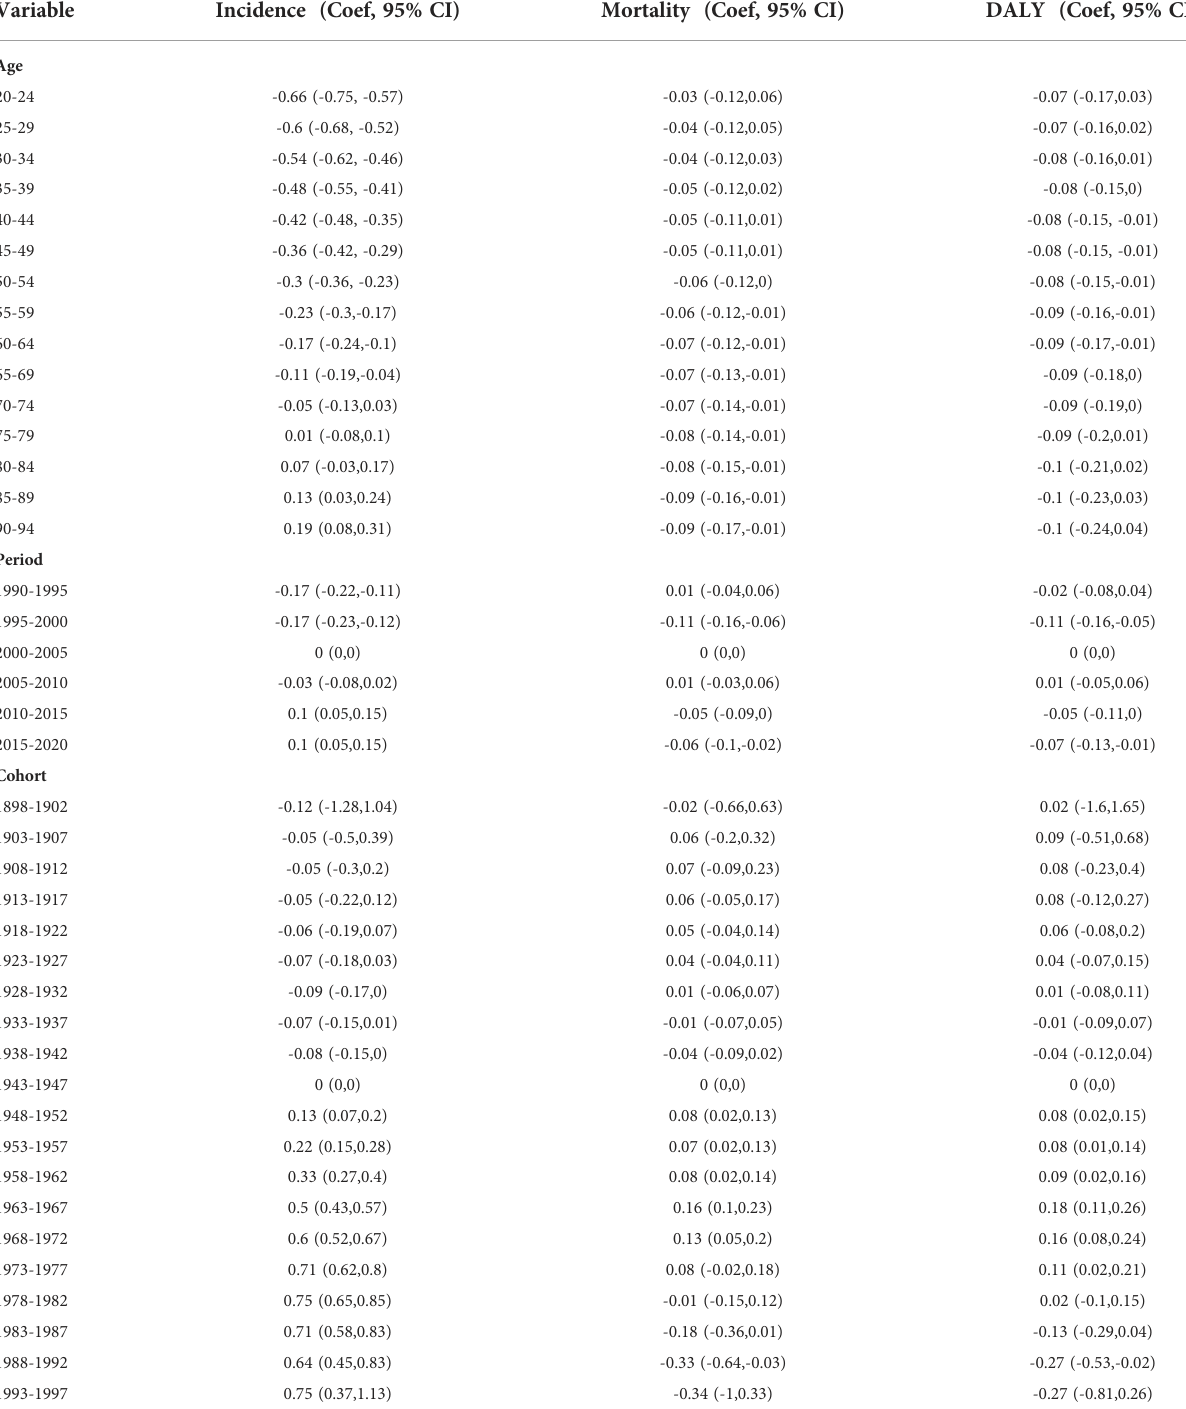
TABLE 4 Age-period-cohort (APC) model analysis results of cervical cancer incidence, mortality and DALY rates in China. Variable Incidence (Coef, 95% CI) Mortality (Coef, 95%